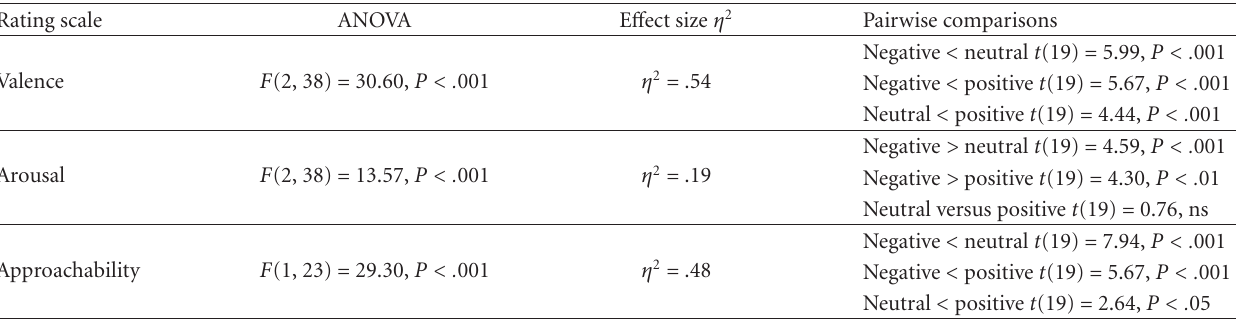
Figure 1: (a) Averaged heart rate responses and SEM to the negative, neutral, and positive words during the period of five seconds after the stimulus o ff set. (b) Averaged second-by-second heart rate changes by stimulus categories during the stimulus and five seconds after the stimulus o ff set. Table 1: Statistical results of the ratings of valence, arousal, and